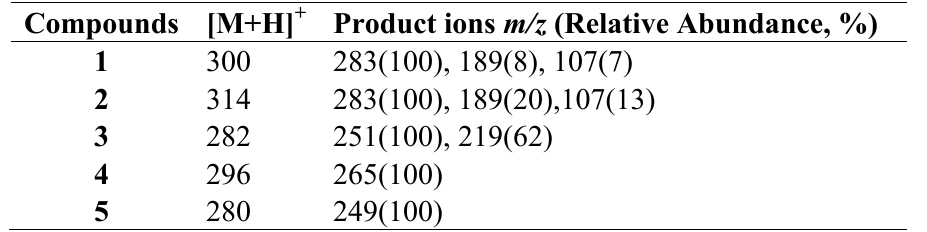
Table 1. Main MS 2 fragments of compounds 1 – 5